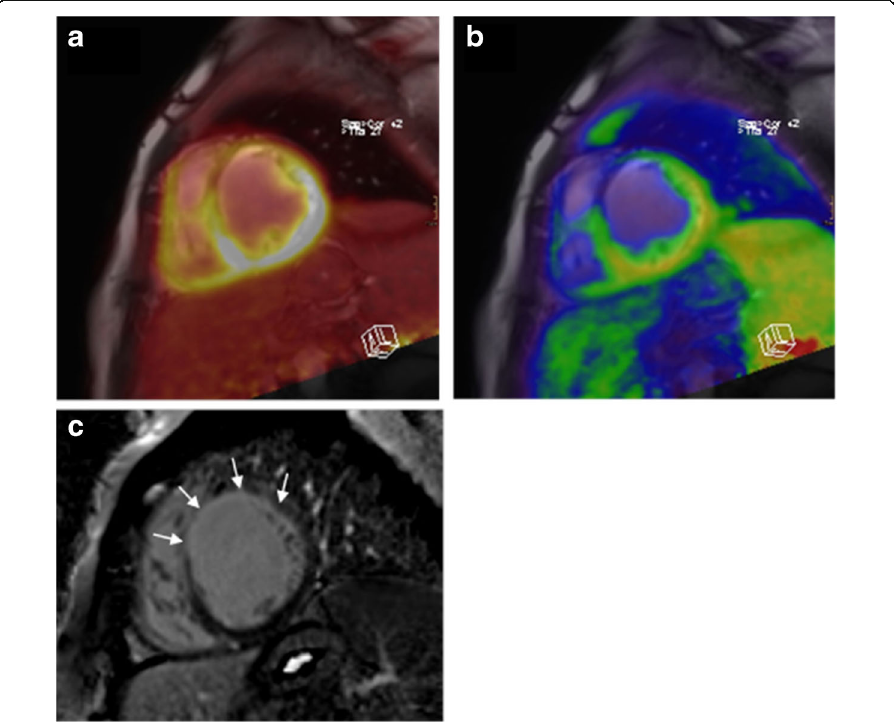
Fig. 4 Cardiac PET/MRI of a 57-year-old male patient with advanced coronary artery disease and deteriorated LV function showing an agreement of missing 18 F-FDG and 13 N-NH3 uptakes with presence of transmural late gadolinium enhancement in the anterior wall of the myocardium, which was rated as transmural scar. (A) Image fusion of 18 F-FDG PET and LGE MRI. (B) Image fusion of 13 N-NH3 PET and LGE MRI. (C) Extent and transmurality of scar determined by MRI